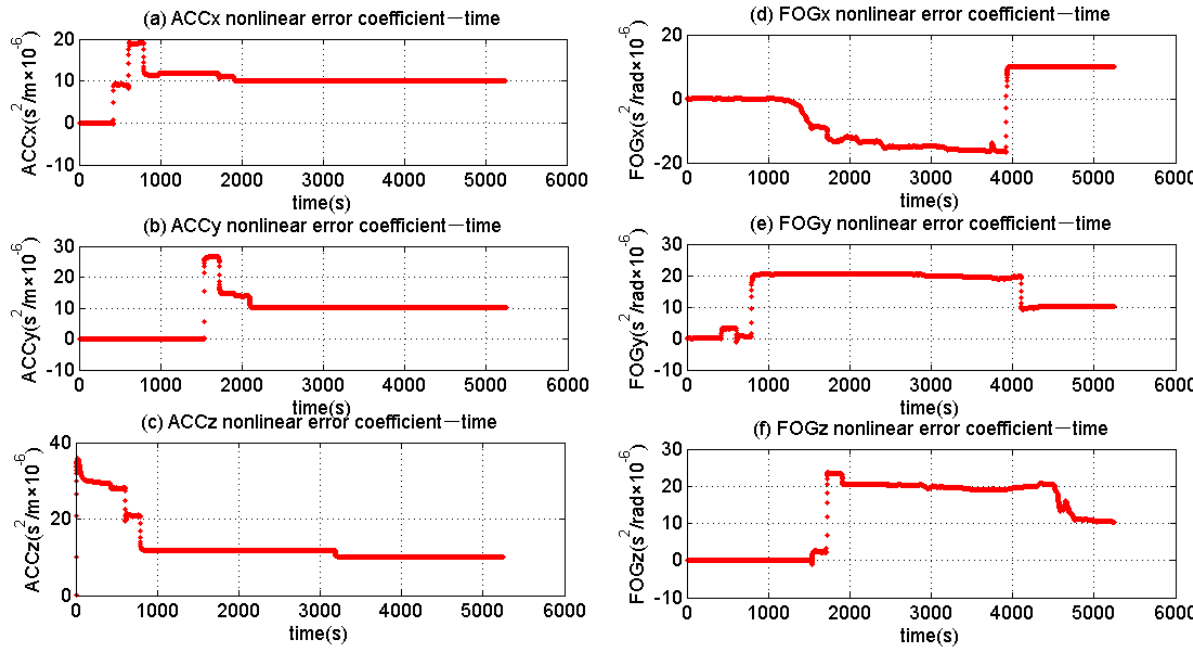
Figure 9. The estimated results of the nonlinear error. Table 3 lists the estimated results of the error items by the linear EKF and nonlinear EKF.